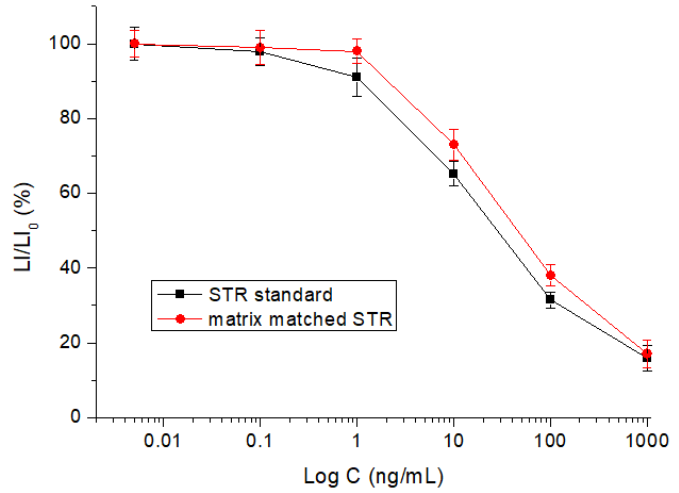
Figure 7. Competitive curves of STR standard and matrix ‐ matched STR (0.01–1000 ng/mL).